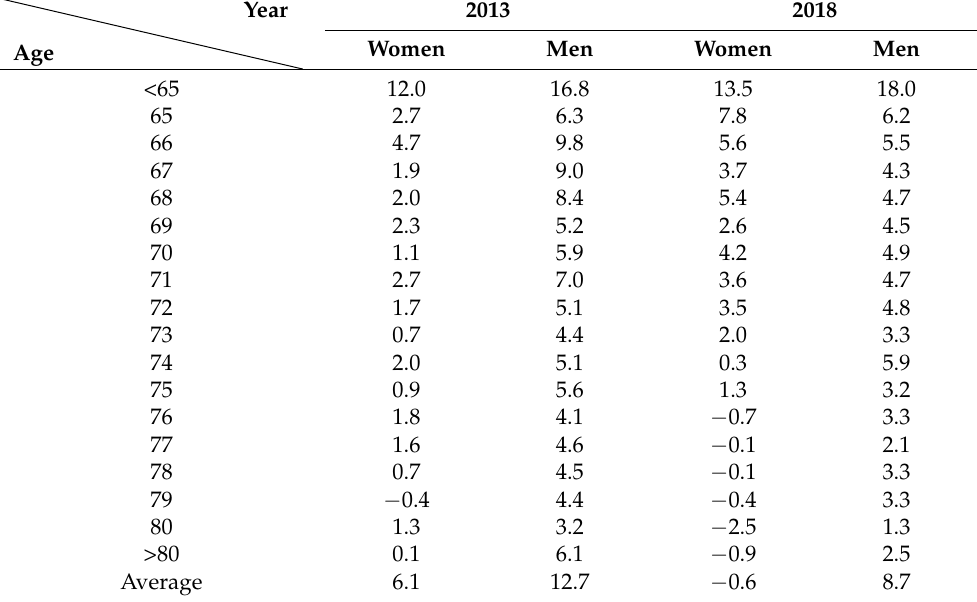
Table 2. Income and life expectancy ratio by age (in